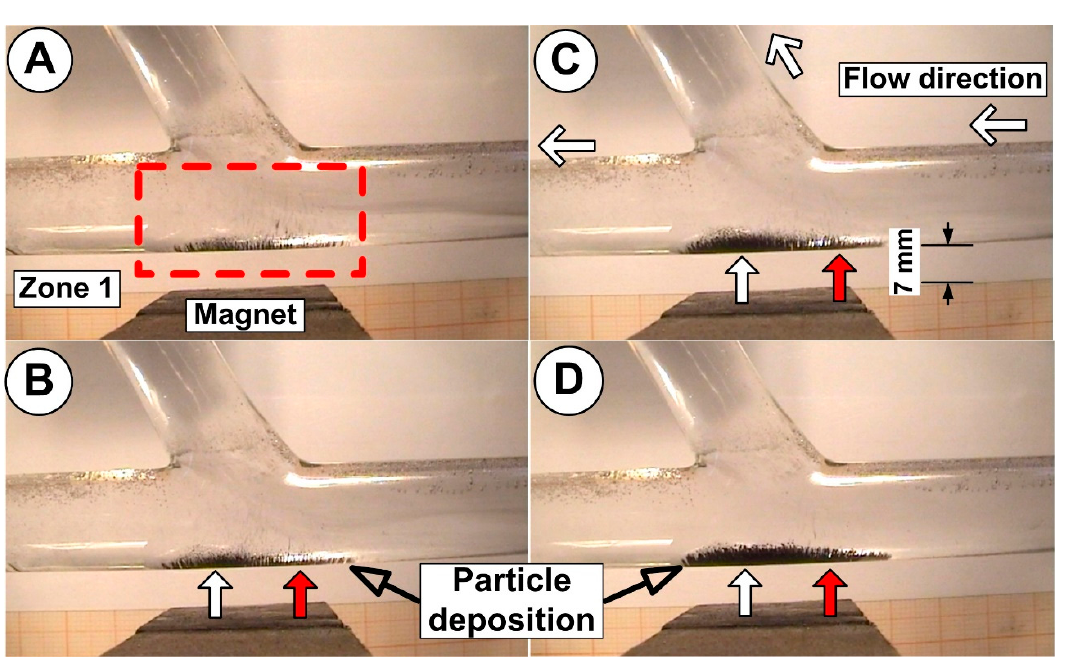
Table 7. Characteristics of the particle accumulation for different magnet distances.